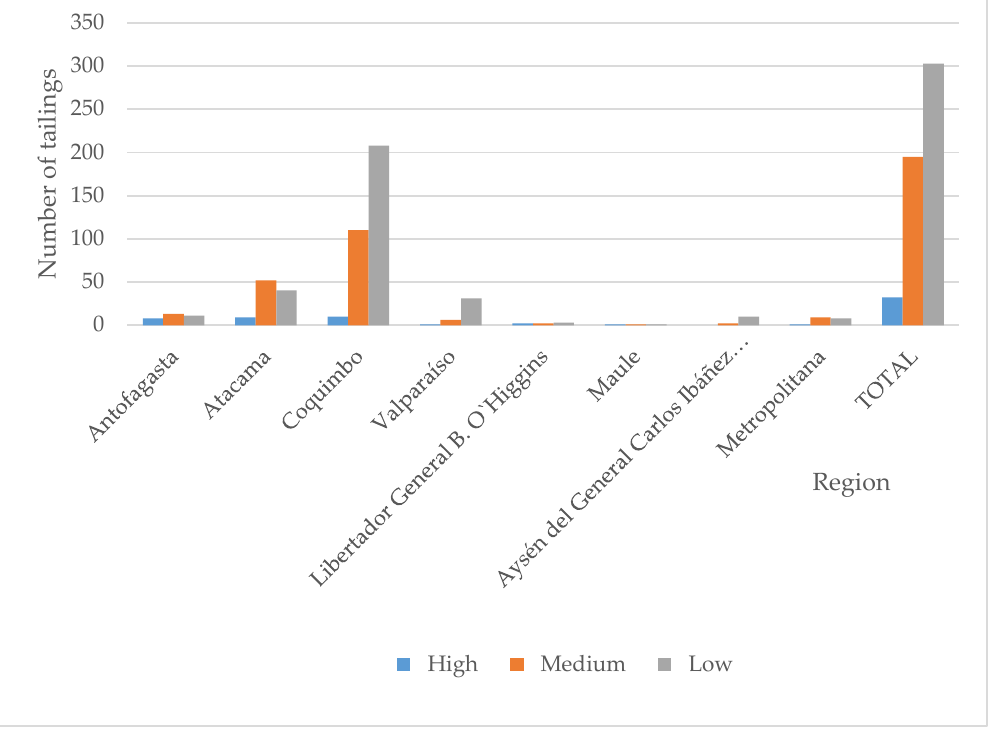
Figure 3. Priority classification of Chilean tailings by region.